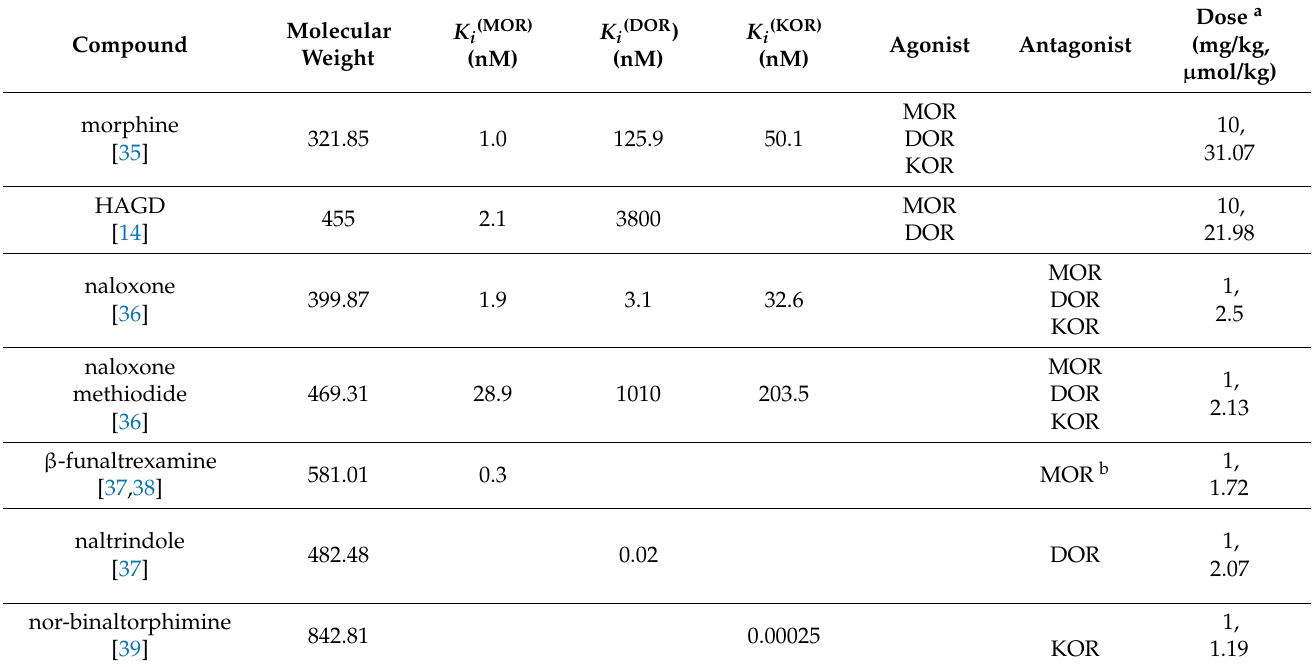
Table 2. The actions of agonists and antagonists at opioid